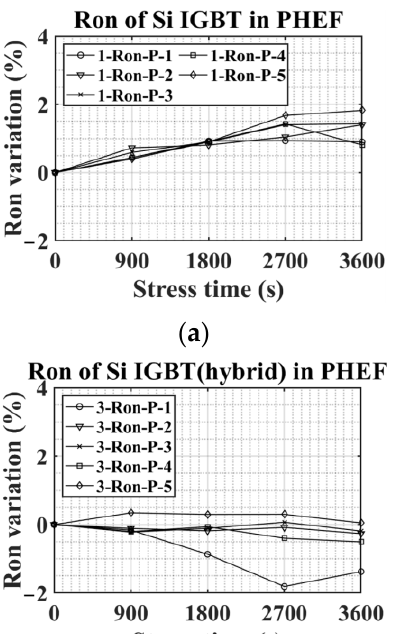
Figure 9. R on variations in PHEF stress: ( a ) Si IGBT, ( b ) Si MOSFET, ( c ) Si IGBT with SiC diode,and ( d ) SiC MOSFET.